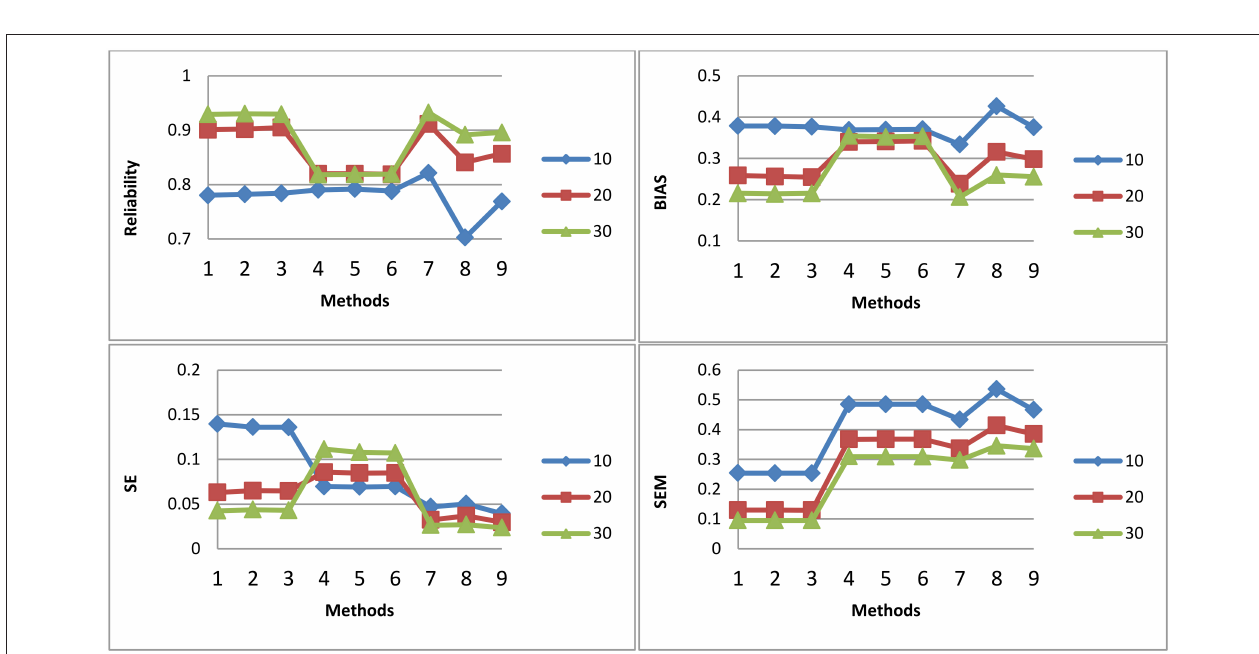
FIGURE 1 | Reliability, BIAS, empirical SE, and SEM for test length of 10, 20, and 30 for all 9 procedures for selection method M1.